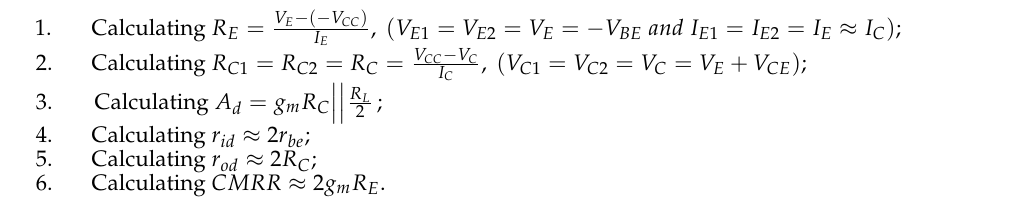
Algorithm 3: Design of input stage Preliminary data: choice of low power transistor and its parameters, taken from